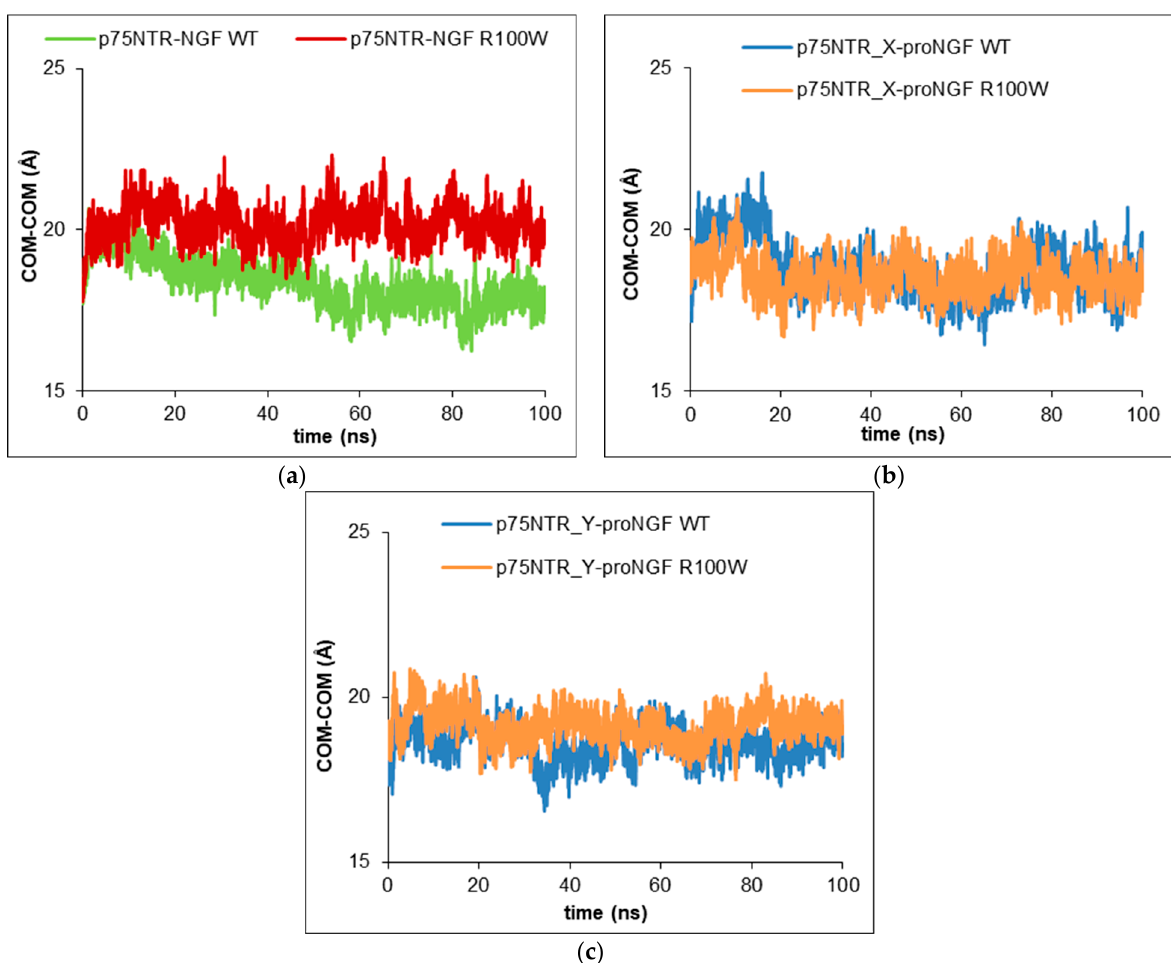
Figure 4. Plots of the centres of mass distance of the complexes: ( a ) p75NTR/NGF, ( b ) p75NTR_X/proNGF, and ( c ) p75NTR_Y/proNGF.